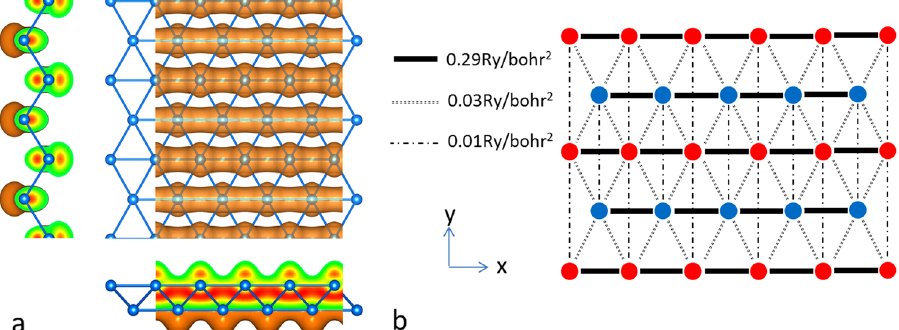
Fig. 4 Electron density distribution and force distribution in borophene. a Isosurface plot at 0.15 Å − 3 for electron density distribution of borophene in both top and side views. b Top view of interatomic force strength. The red atoms are in the upper plane and the blue ones are in the lower plane . The different types of lines illustrate the longitude IFCs of the nearest neighbor atoms at each direction